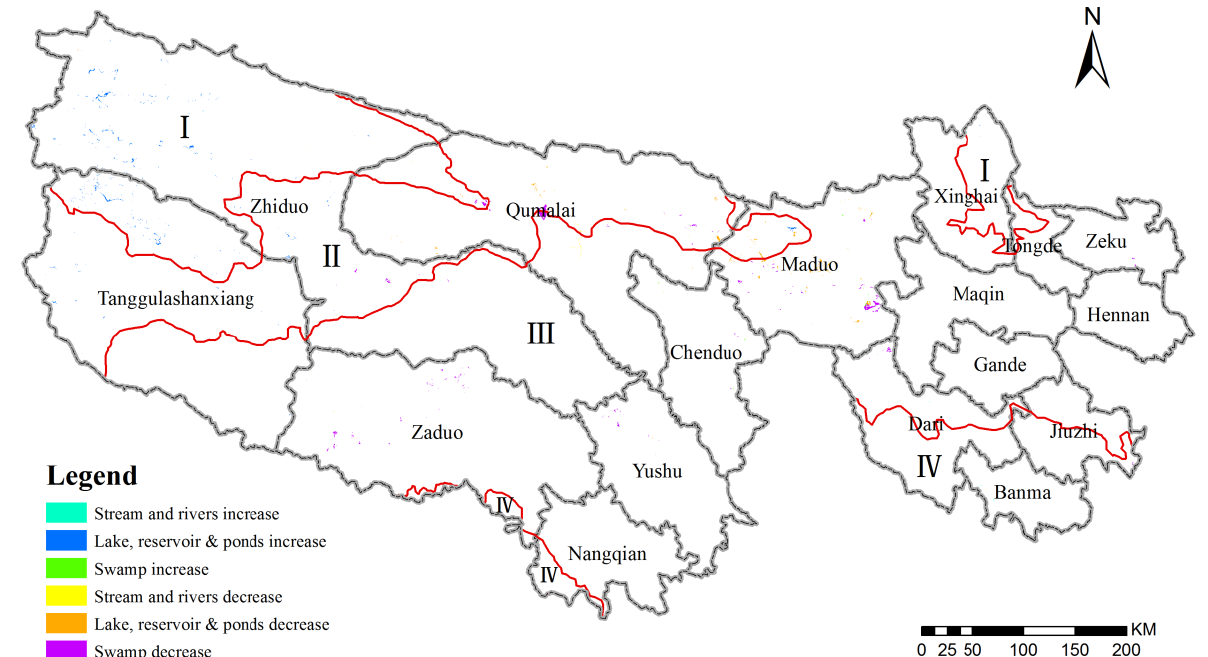
Figure 4. The distribution of wetland changes in the TRH region from the early 1990s to 2004 (humidity Region I: 0.3–0.4; II: 0.4–0.5; III: 0.5–1; and IV: >1).